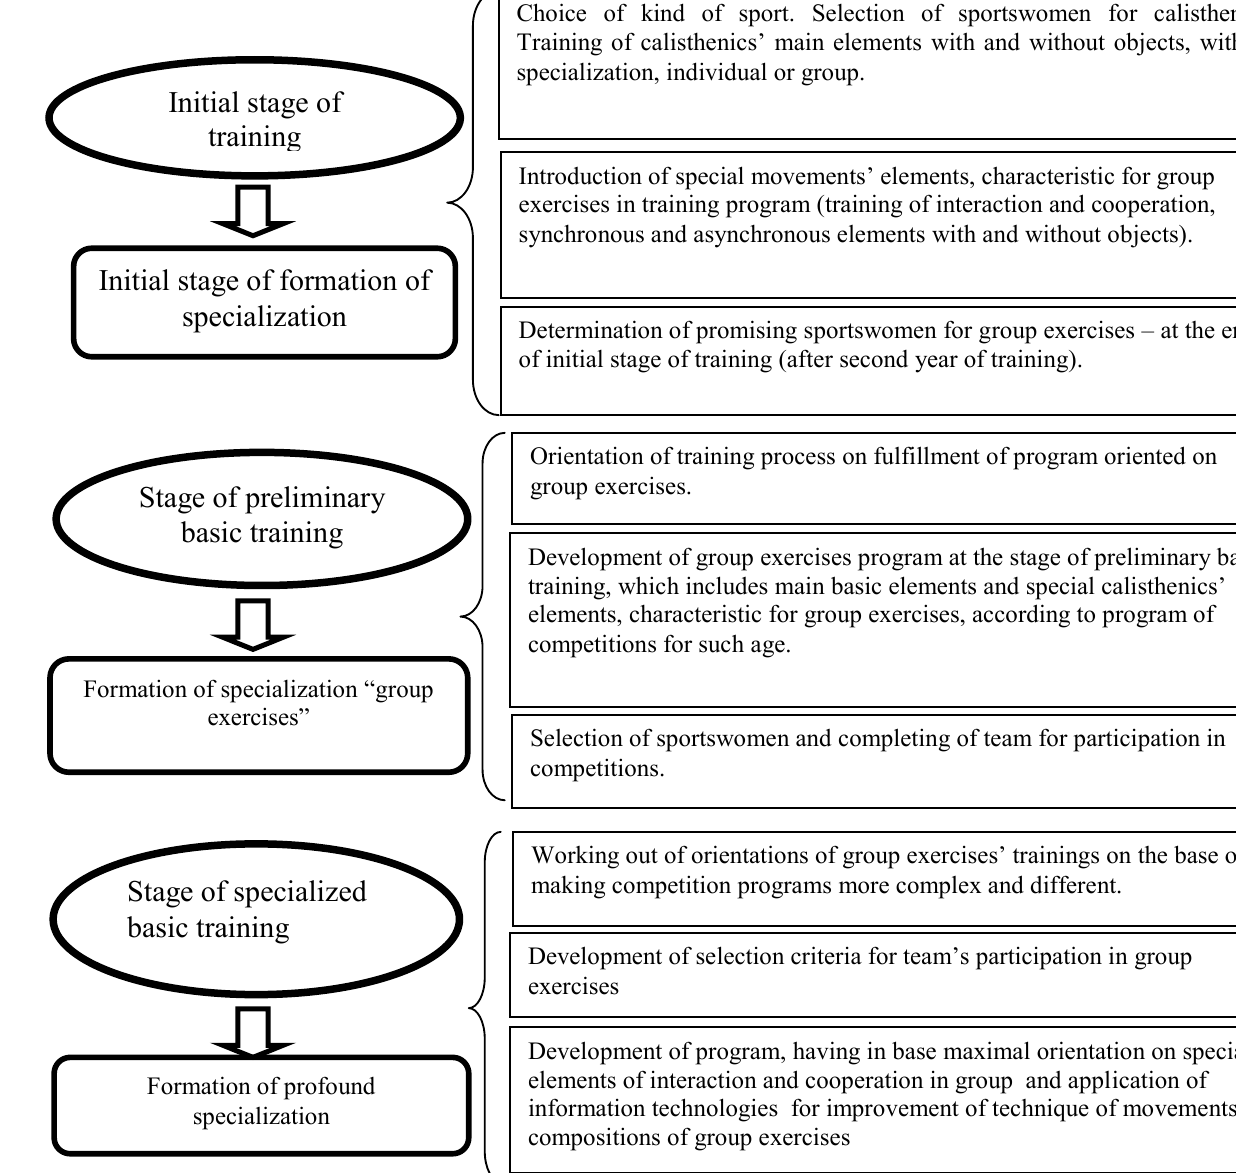
Fig.1. Structural diagram of formation of specialization “group exercises” in